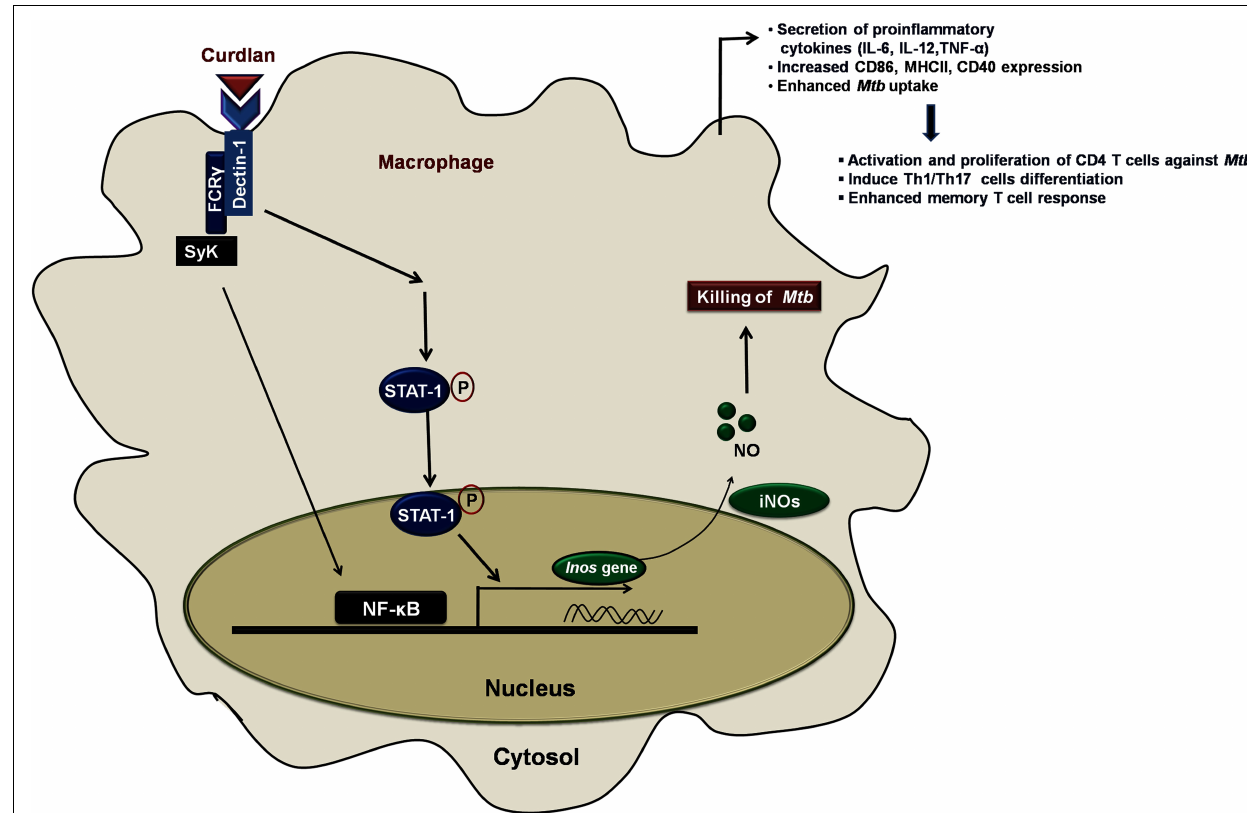
FIGURE 9 | Curdlan induced signaling pathways and events in Mtb infected M (cid:56) s. This proposed model illustrates the signaling events involved in restricting the Mtb growth. Curdlan binds to its receptor, dectin-1 and induces the STAT-1 phosphorylation in Mtb infected M (cid:56) s. This leads to the pSTAT-1 mediated activation of iNOS gene to generate NO, which has antimicrobial properties to restrict the Mtb survival. Subsequently, there is activation and translocation of NF- κ B into the nucleus. These signaling pathways activate and boost the function of M (cid:56) s (increased proinflammatory cytokines, bacterial uptake, expression of costimulatory molecules) which further elicit the protective effector and memory T cell response against Mtb